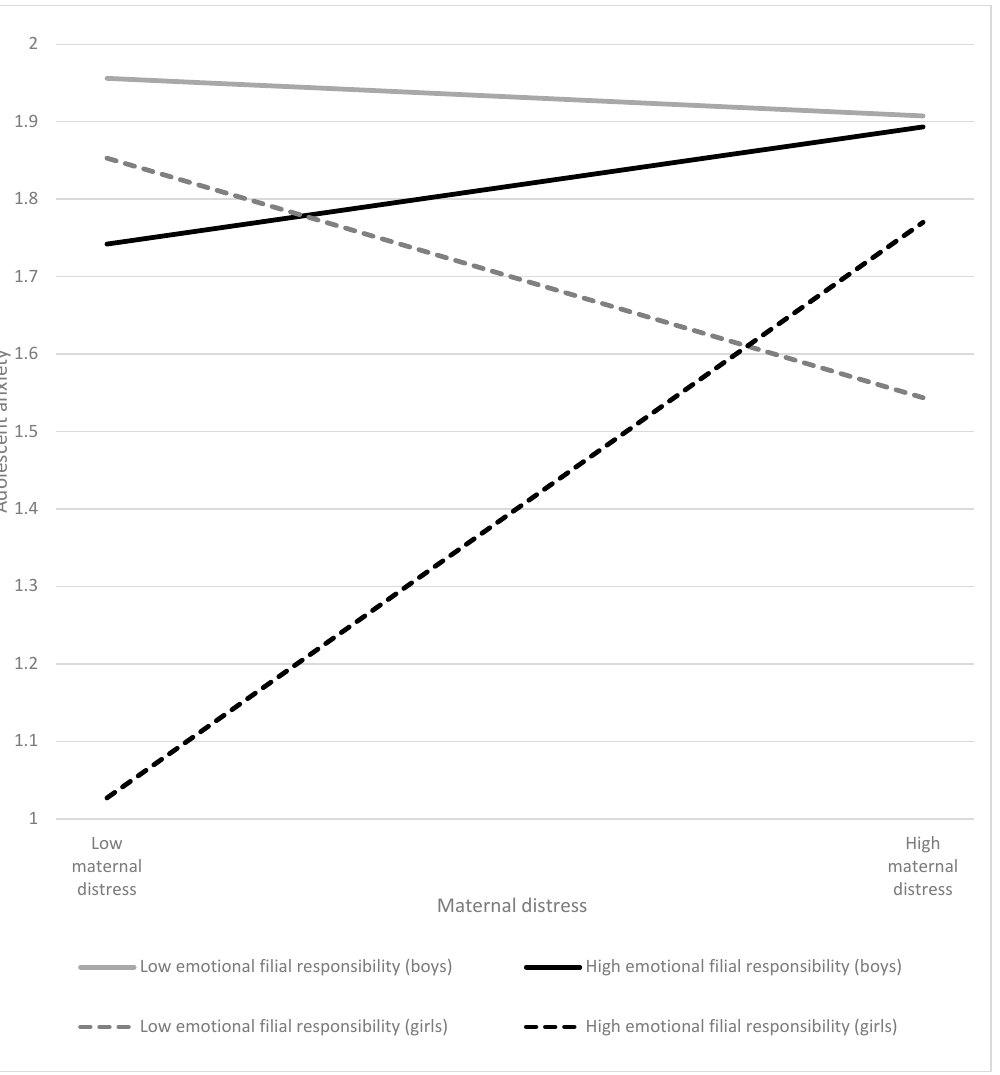
Figure 3. Regression of adolescent anxiety by maternal distress in high and low levels of emotional filial responsibility between adolescent boys and girls.